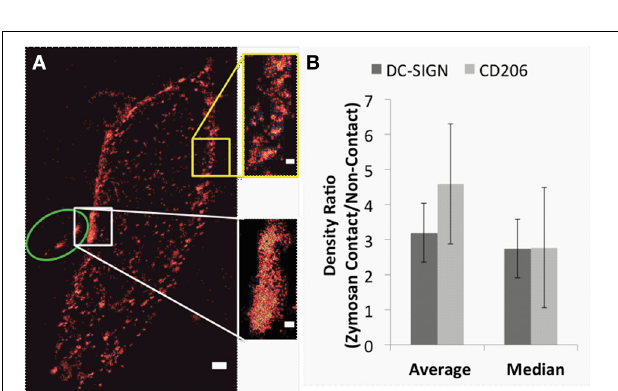
conventional confocal fluorescence microscopy and integrated over the entire three-dimensional contact site. Statistical significance was determined by ANOVA and Tukey’s post-hoc test with n = 37 for 1 and 4h and n = 24 for 0h. ∗∗∗ Indicate a statistically significant difference at the level of p < 0 . 0005 between the designated time points.